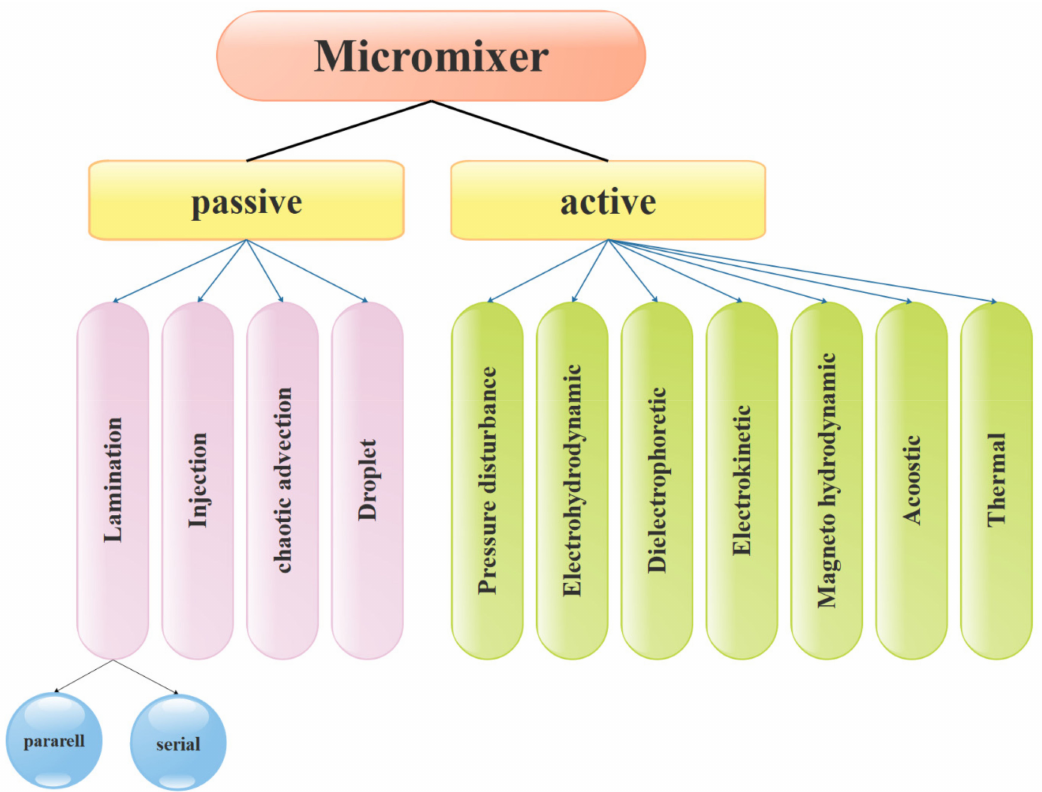
Figure 27. Classification of micromixers